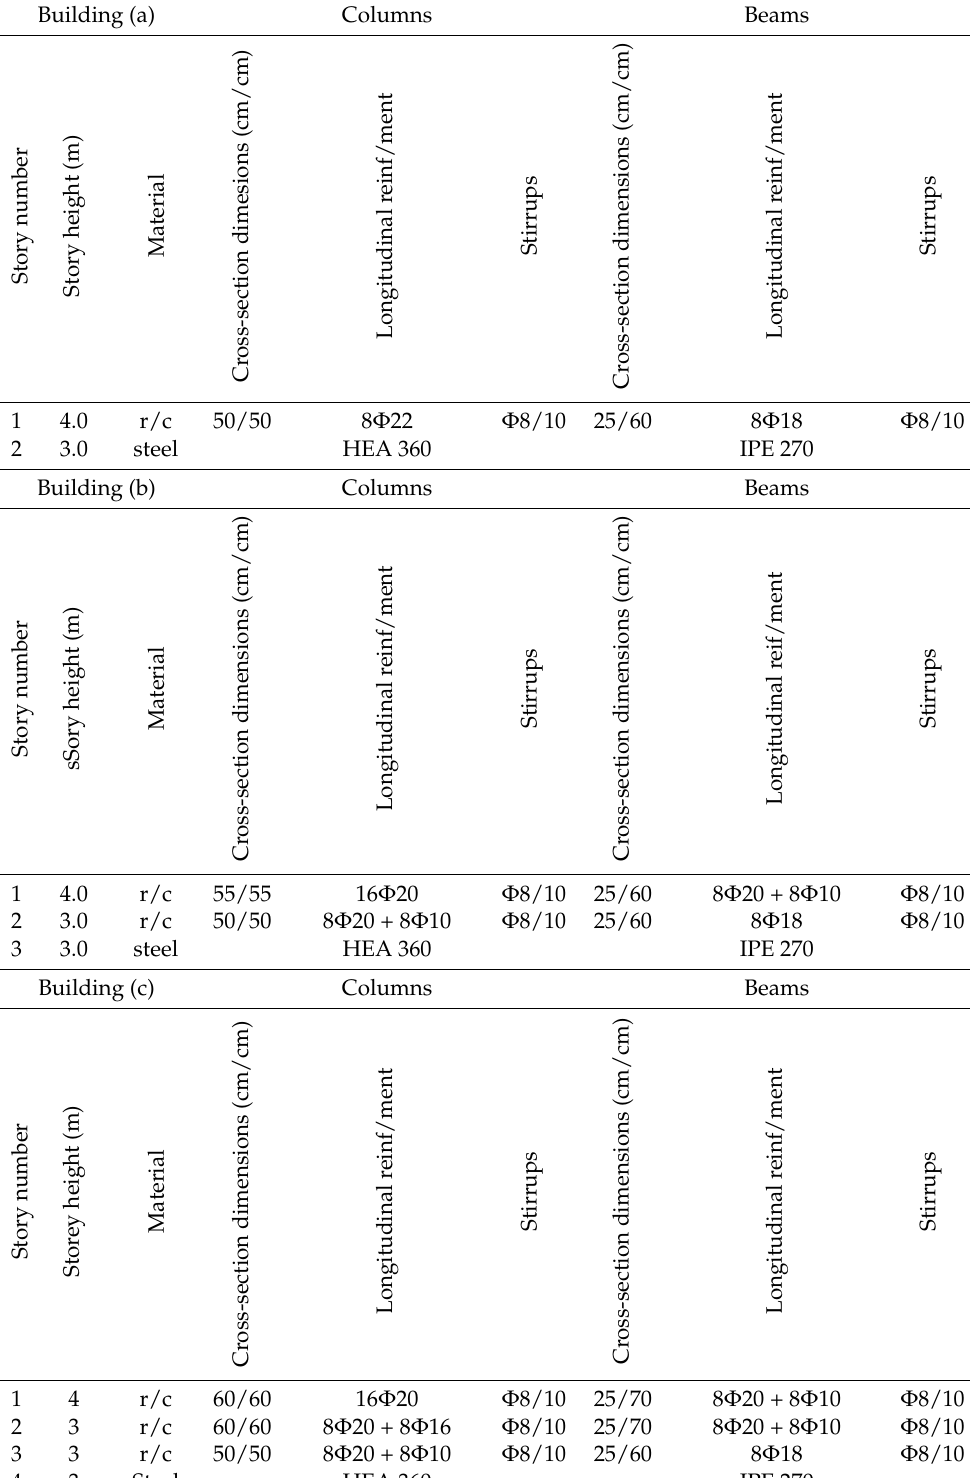
Table 1. Sections of columns and beams for the mixed buildings (a)–(e) shown in Figure 1. Building (a) Columns